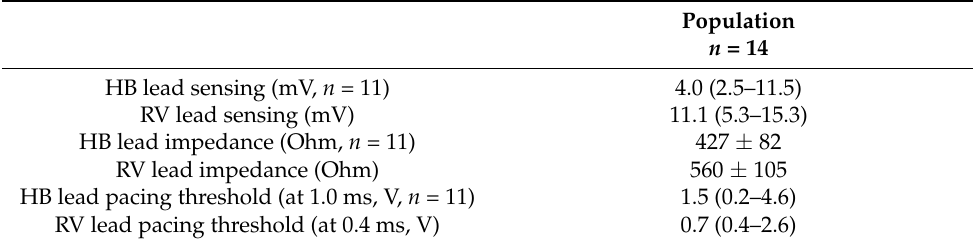
Table 4. One month